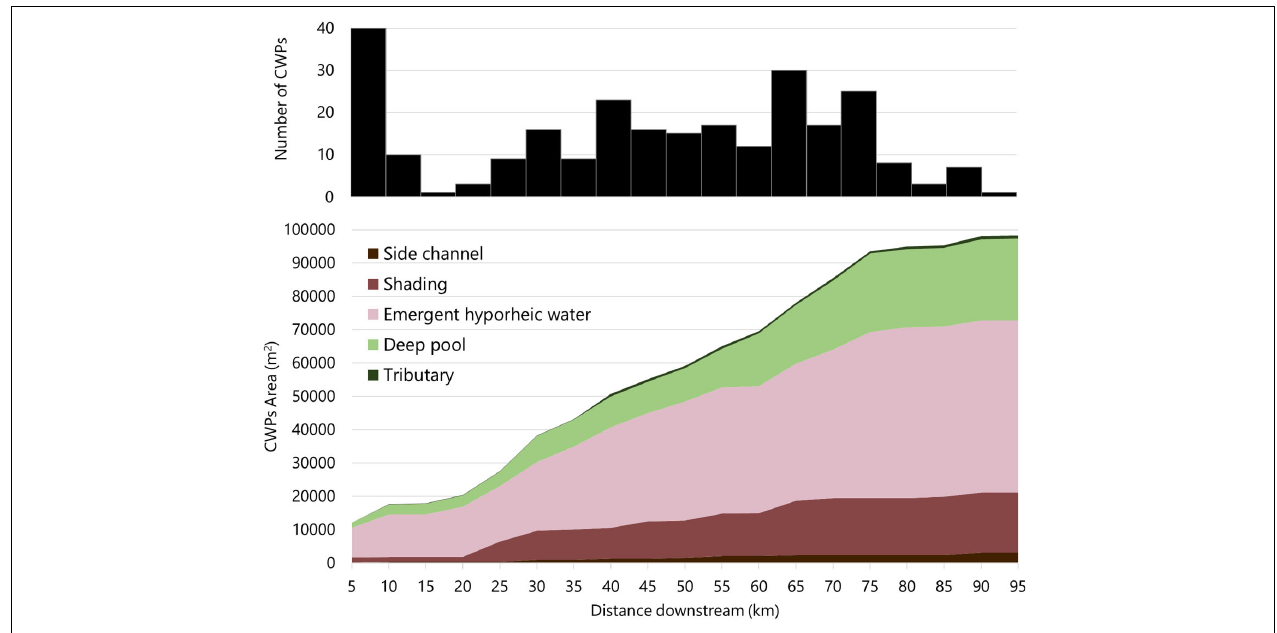
FIGURE 7 | Distribution of CWP numbers (top) and cumulative distribution of CWP types by occupied area (bottom) along the Upper Ovens River. TABLE 2 | Outputs of the general linear model of the relationship between thermal differences promoted by CWPs (square-root transformed) and hypothesized predictions. Regression coefficients ANOVA p- values Estimate SE t -value SS DF